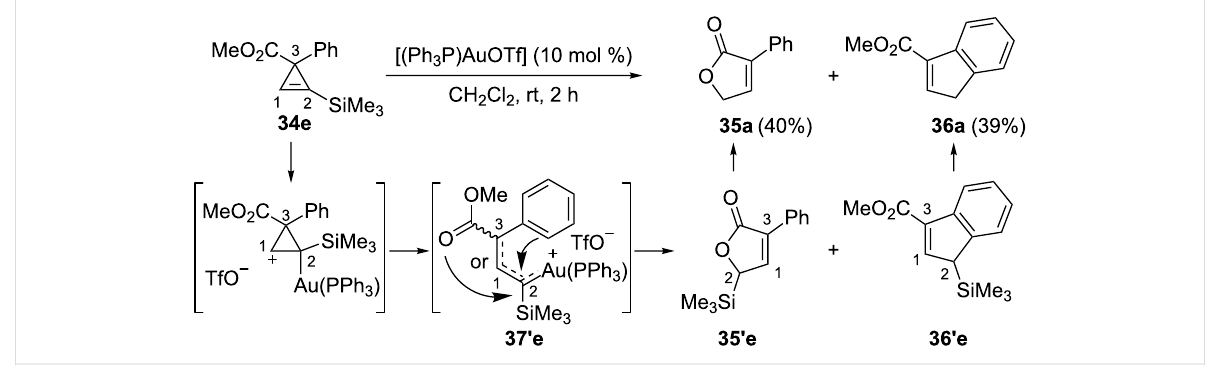
Scheme 17: Gold-catalyzed reactions of cyclopropenylsilane 34e .